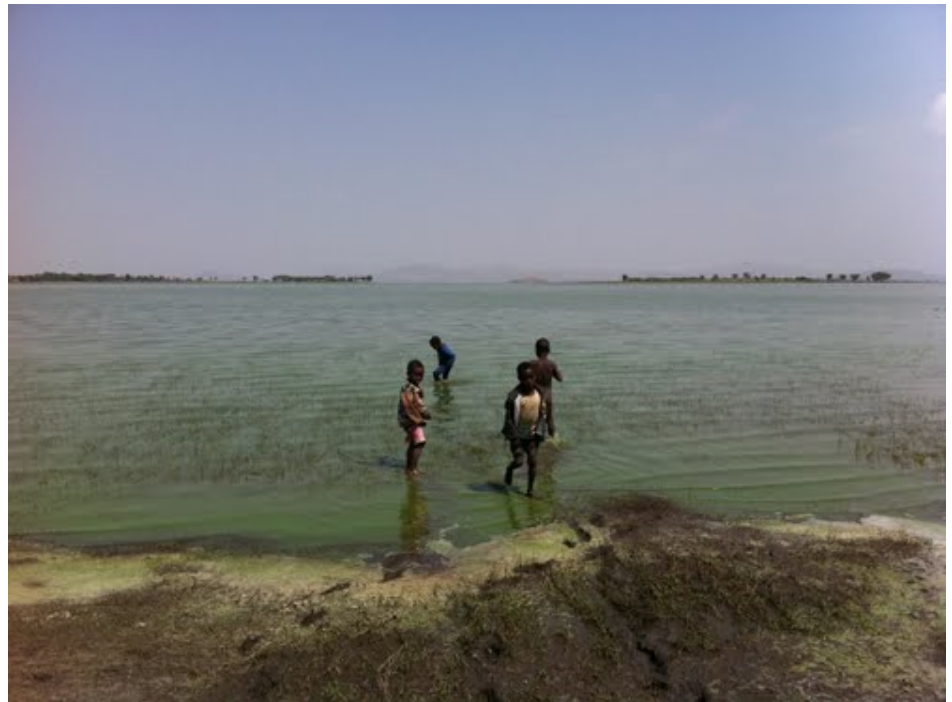
Figure 1. Qooqa Lake, southeast of Finfinne. Courtesy of Geoview.info.